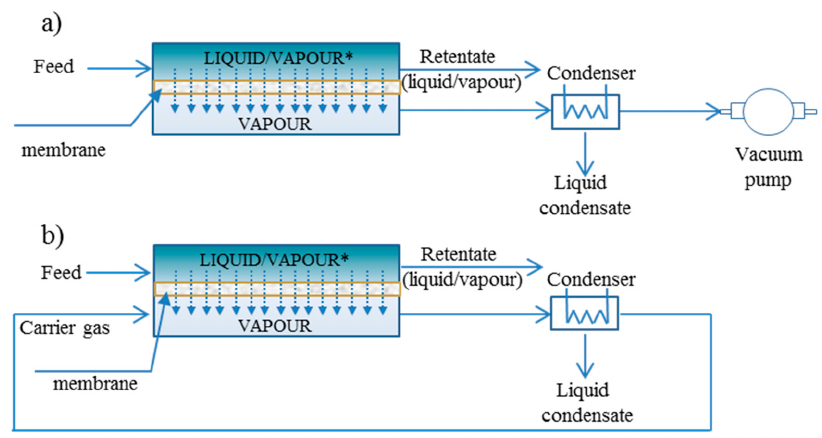
Figure 1. Schematic PV or VP process: ( a ) by vacuum; ( b ) by carrier gas. * For PV, the feed is liquid; for VP, the feed is vapor.